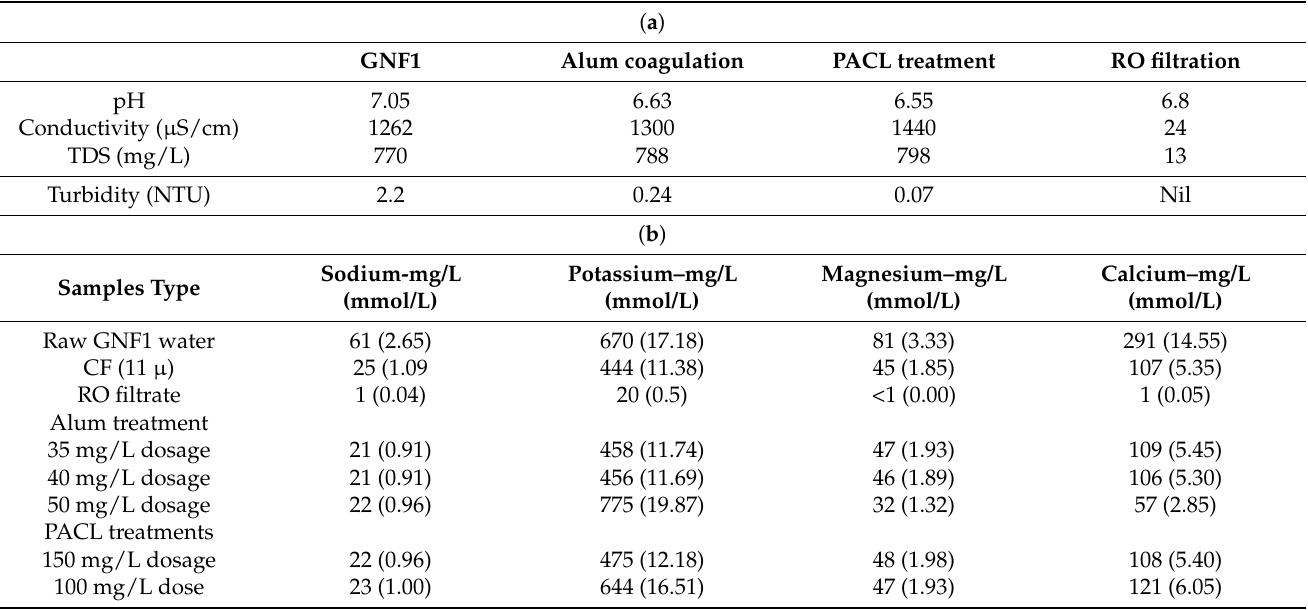
Table 2. ( a ) Results of GNF1 and treated GNF1 water from GH1. ( b ) Metals analysis results in GNF1 and treated